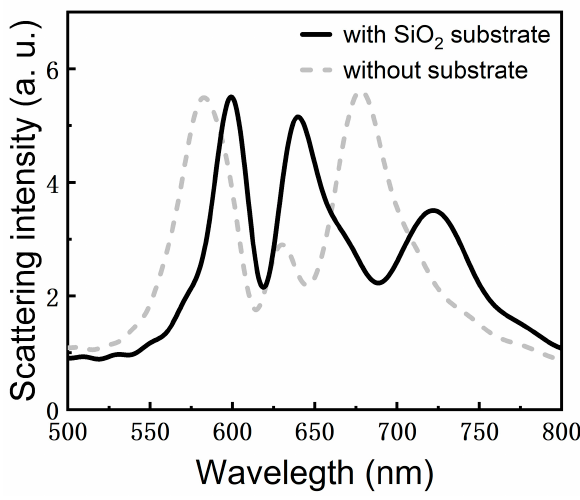
Figure 8. Scattering spectrum calculated for a GNR dimer placed on a SiO 2 substrate with an embedded WS 2 monolayer (black solid curve). The scattering spectrum of the hybrid structure in the absence of the substrate is also provided for comparison (dashed curve).